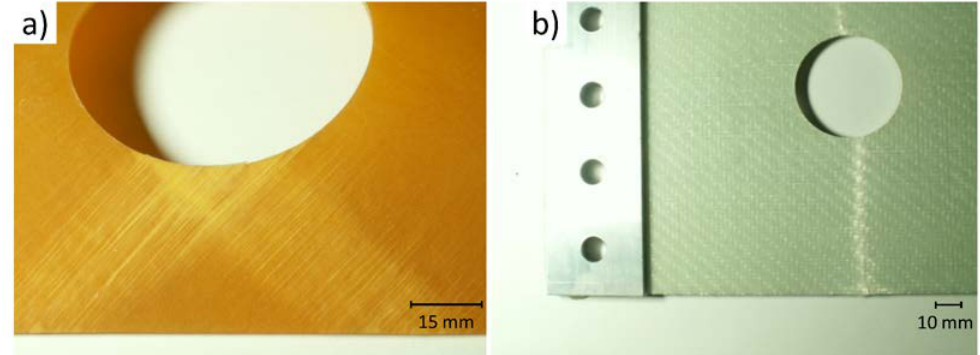
Figure 5. Photographs of cracks in composite panels: ( a ) shallow cylindrical panel [+45°/ − 45°] 4 , ( b ) plate made of woven-roving fabric.